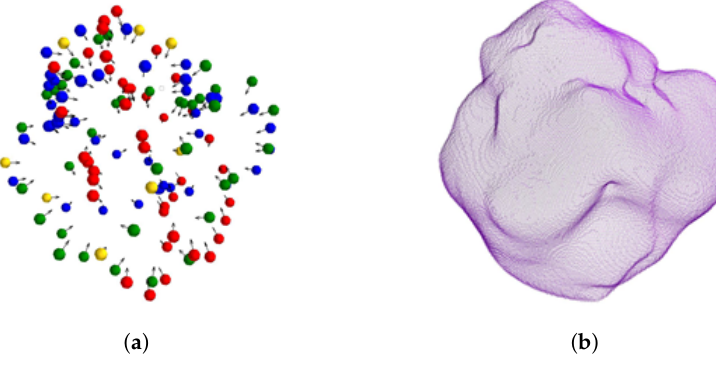
Figure 7. ( a ) 3D Interpolation using radial basis function (RBF); ( b ) implicit surface of the